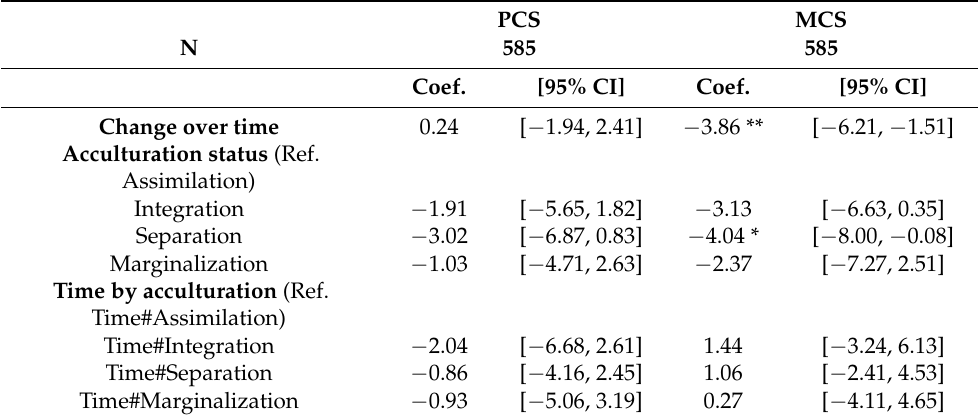
Table 3. Change over time in health-related quality of life and acculturation status (hierarchical linear regression).